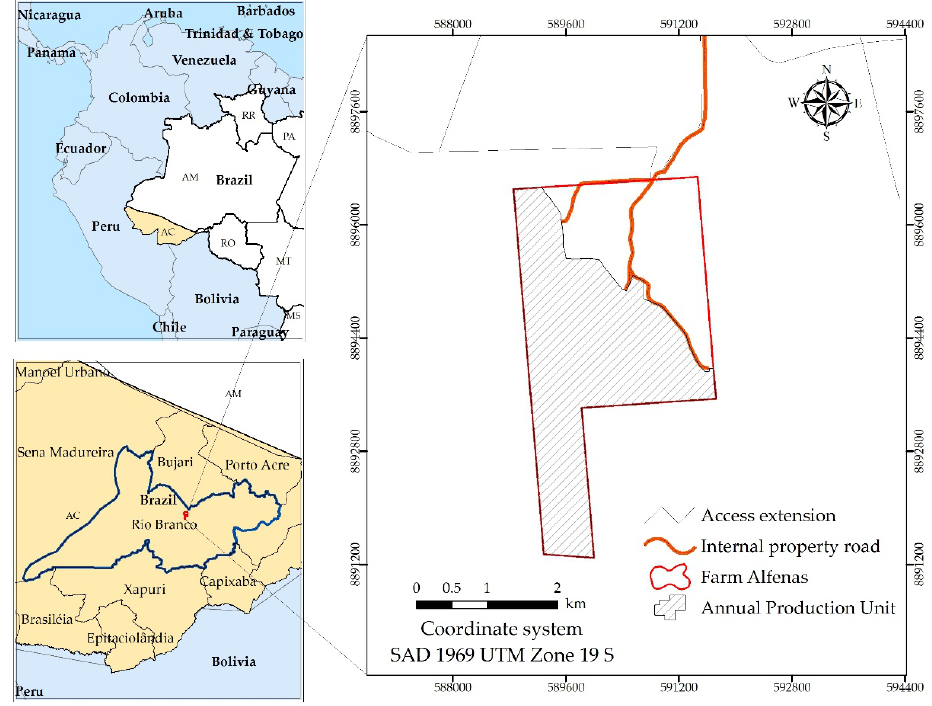
Figure 1. Location of the study area.